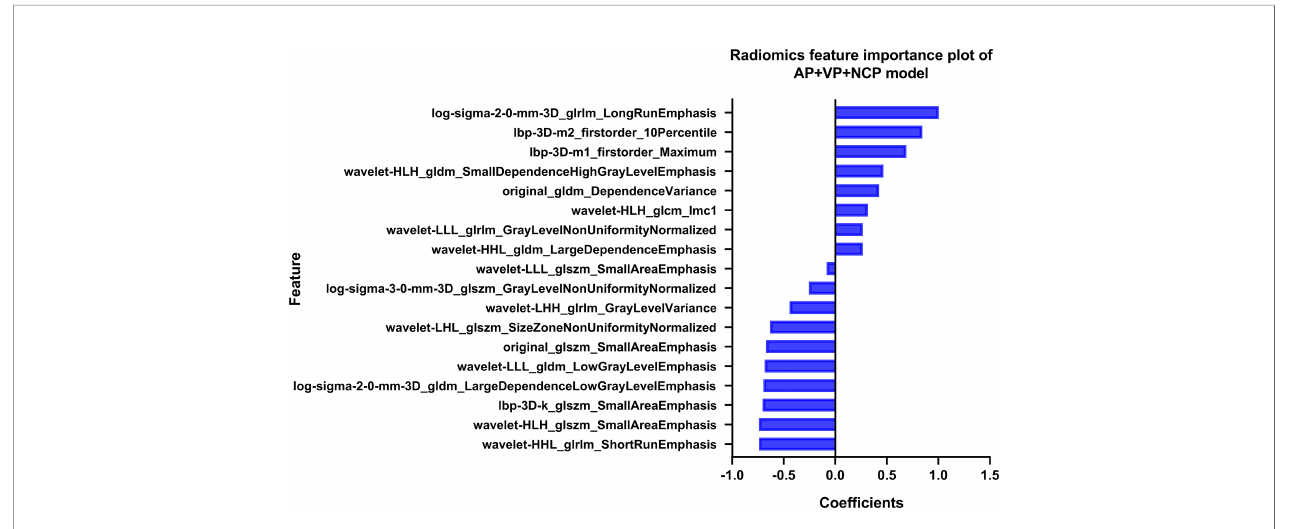
FIGURE 3 | The coef fi cients of radiomics features in our AP+VP+NCP model developed by LR classi fi